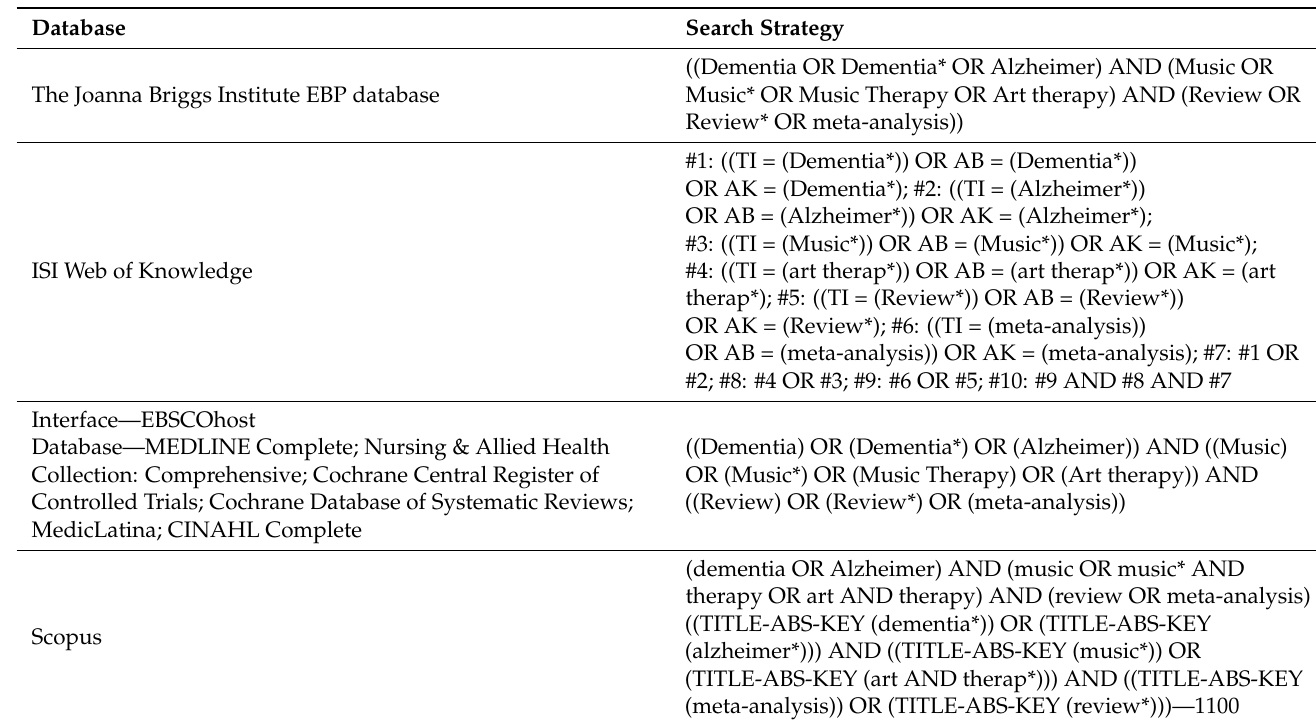
Table 2. Search strategy